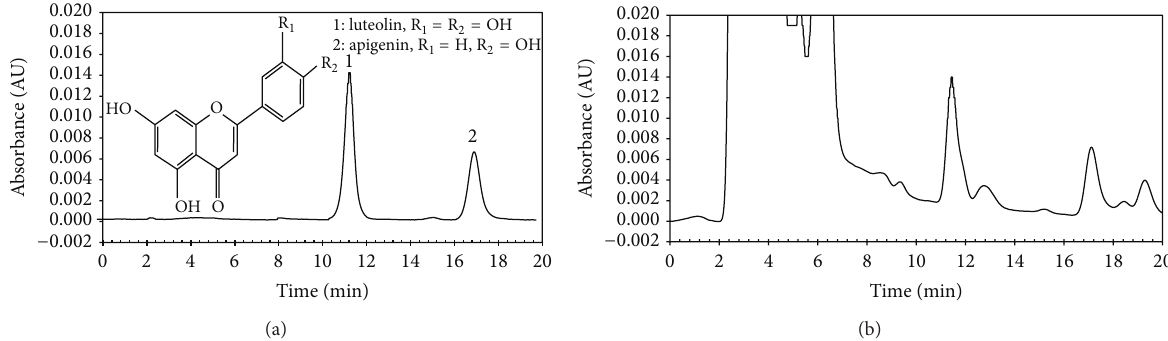
Figure 1: The HPLC profiles of a mixture of standards of luteolin and apigenin (a) and the two compounds in an extract obtained by MAE using 70% ethanol as extraction solvent